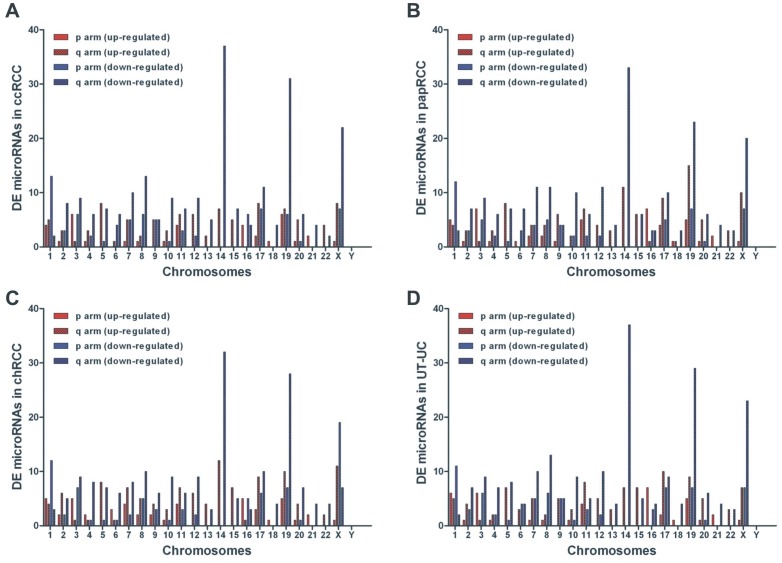
Correlation of miRNA deregulation and chromosomal aberrations.Chromosomal mapping for the deregulated miRNAs in ccRCC (A), papRCC (B), chRCC (C) and UT-UC (D). In ccRCC, the up-regulated miRNAs were mainly mapped on chromosomes Xq, 17q, 5q, 14q, 19q, 11q, 12q, 3p and 10p (in descending order); whereas the down-regulated ones were mainly mapped on chromosomes 14q, 19q, Xq, 8q, 1p, 17q, 7q, 3q, 10q, 12q and 2q (A). In papRCC, the up-regulated miRNAs were mainly mapped on chromosomes 19q, 14q, Xq, 5q, 3p, 16p, 11q, 9q and 15q; whereas the down-regulated miRNAs were mainly mapped on chromosomes 14q, 19q, Xq, 1p, 7q, 8q, 12q, 10q, 17q, 3q, 19p, Xp, 2q, 5, 6q, 4q, 11q, 15q and 20q (B). In chRCC, the up-regulated miRNAs were mainly mapped on chromosomes 14q, Xq, 19q, 17q, 5q, 7q, 11q, 15q, 2q and 12q; whereas the down-regulated ones were mainly mapped on chromosomes 14q, 19q, Xp, 3p, 8q, 17q, 3q, 10q, 12q, 4q, 7q, 3p, 5q, 19p and 20q (C). In UT-UC, the up-regulated miRNAs were mostly mapped on chromosomes 17q, 19q, 11q, 16p, 5q, 14q, 15q, Xq, 1p and 3p; whereas the down-regulated miRNAs were mainly mapped on chromosomes 14q, 19q, Xq, 8q, 1p, 7q, 12q, 3q, 10q, 5q, 17p, 19p, Xp, 2q, 4q, 3p and 8p (D).